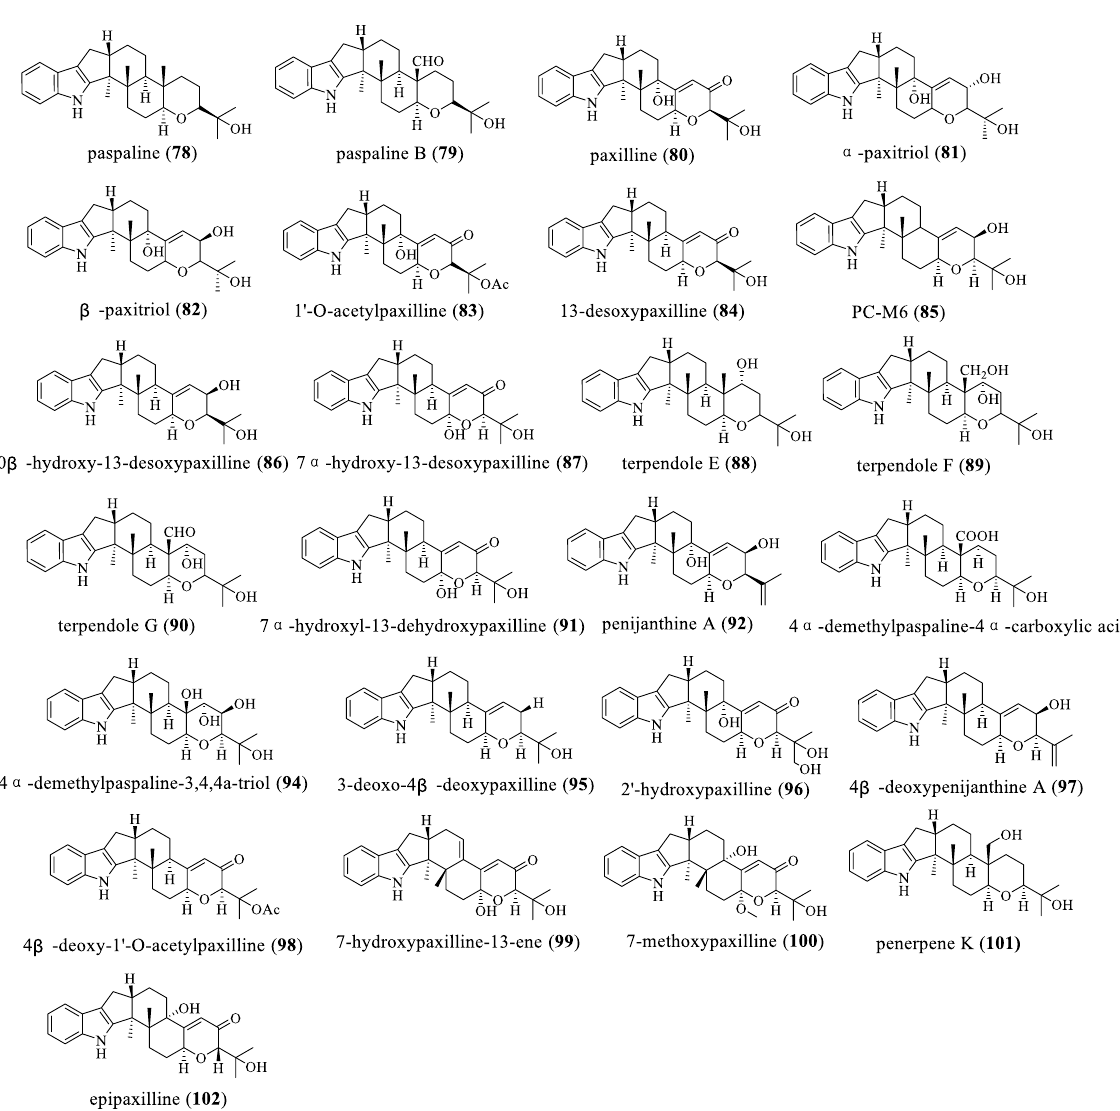
Fig. 7 Chemical structures of paspaline‑type compounds with only a paspaline